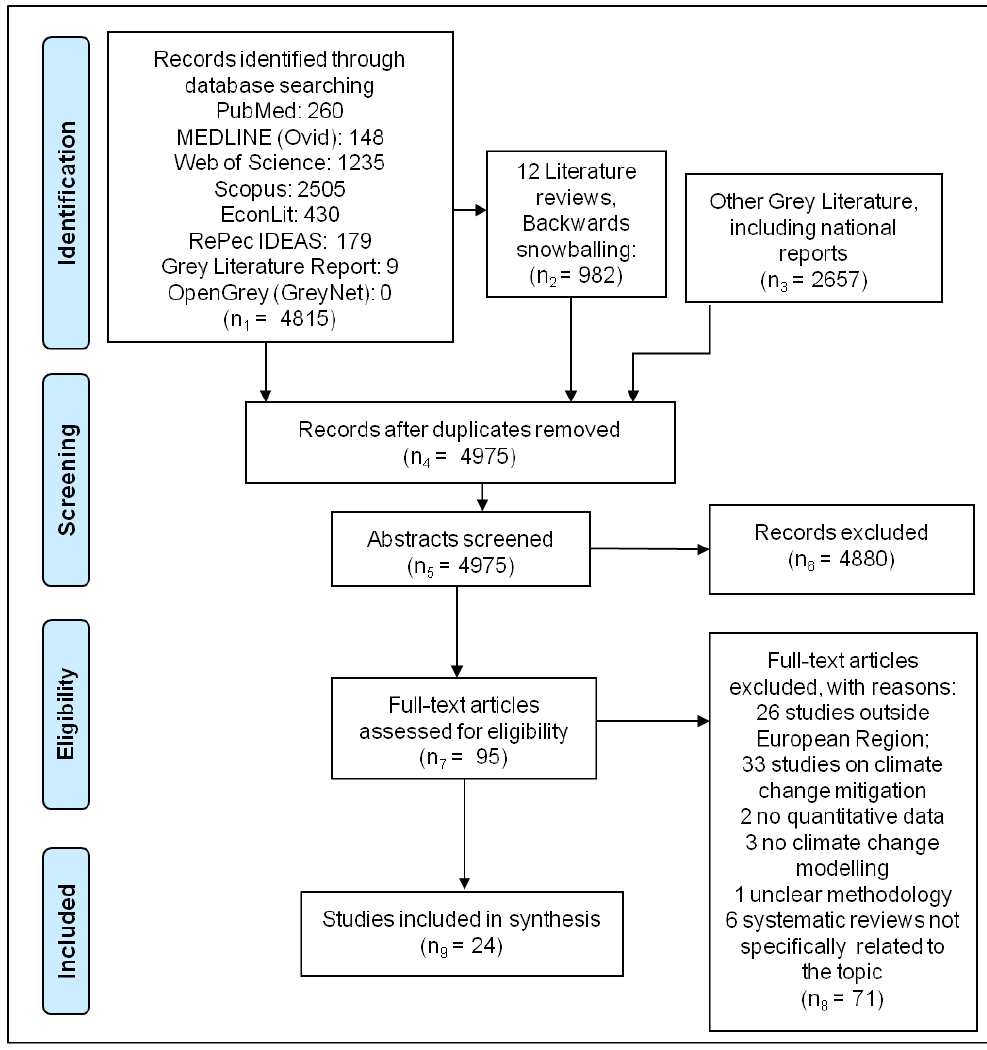
Figure 1. Flow diagram of the review, adapted from the PRISMA methodology